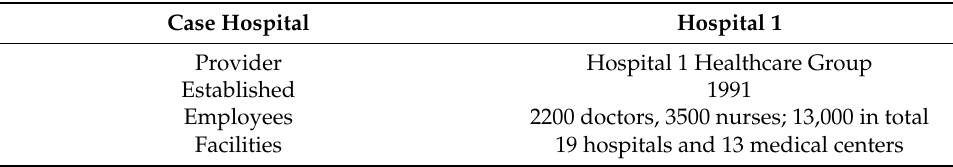
Table 1. H1 Hospital in the in-depth case